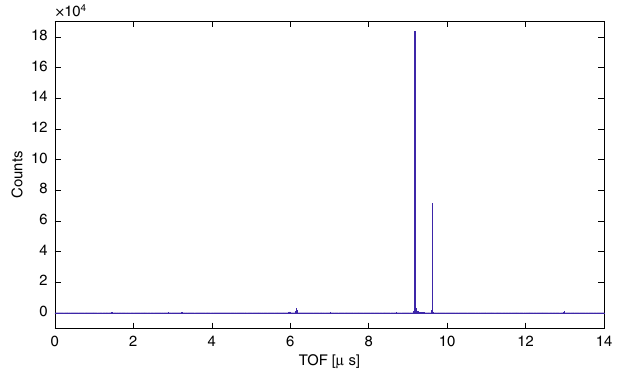
Fig. 6 TOF histogram of detected ions. Zero time stamp is de fi ned by arrival time of electrons. The two main peaks correspond to Ar + and HeAr + . The two smaller peaks at 6.0 and 6.2 μ s correspond to TOF of H 2 O and OH accordingly. The peak at 13 μ s corresponds to TOF of Ar 2